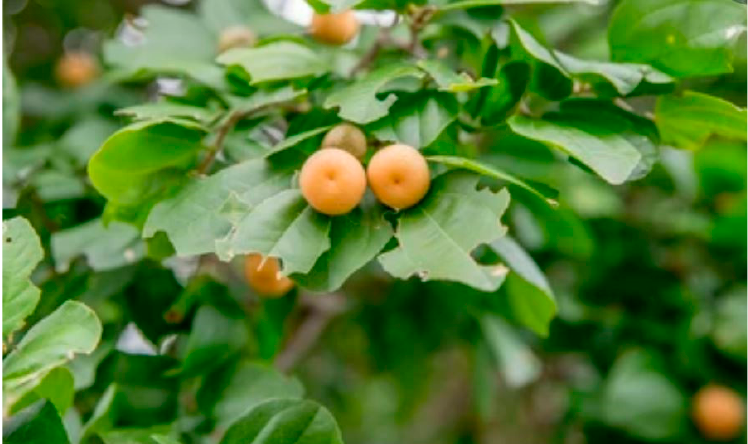
Figure 1. Juá ( Ziziphus joazeiro M.) fruit. Source: https://www.shutterstock.com/pt/image- Figure 1. Ju á ( Ziziphus joazeiro M.) fruit. Source: https://www.shutterstock.com/pt/image-photo/ photo/fruits-de-boi-1076258687 (accessed on 15 January 2022). fruits-de-boi-1076258687 (accessed on 15 January